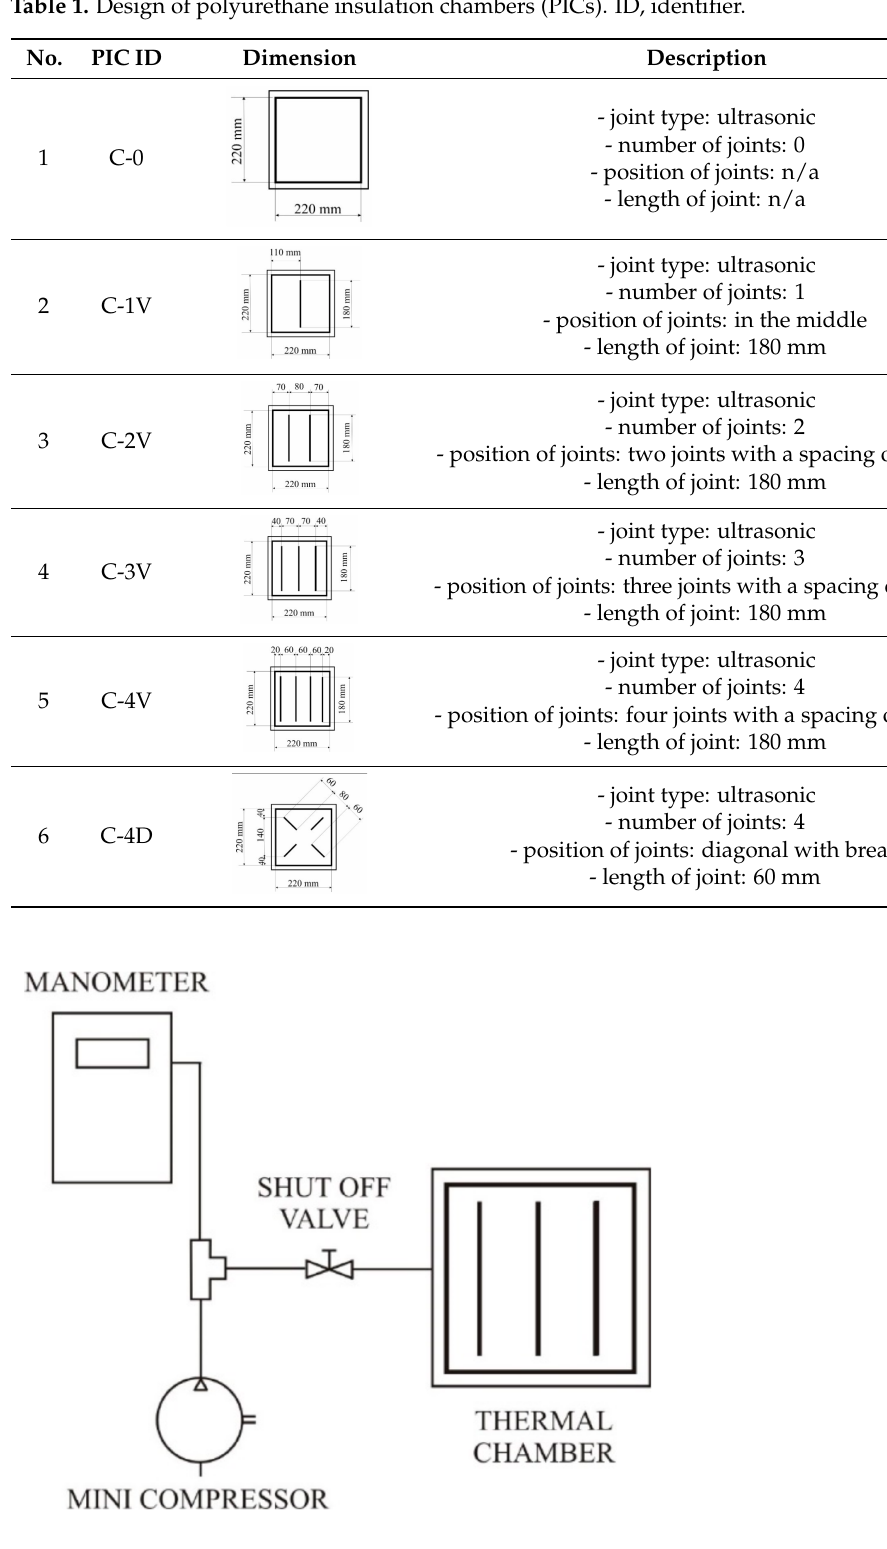
Figure 3. Measuring